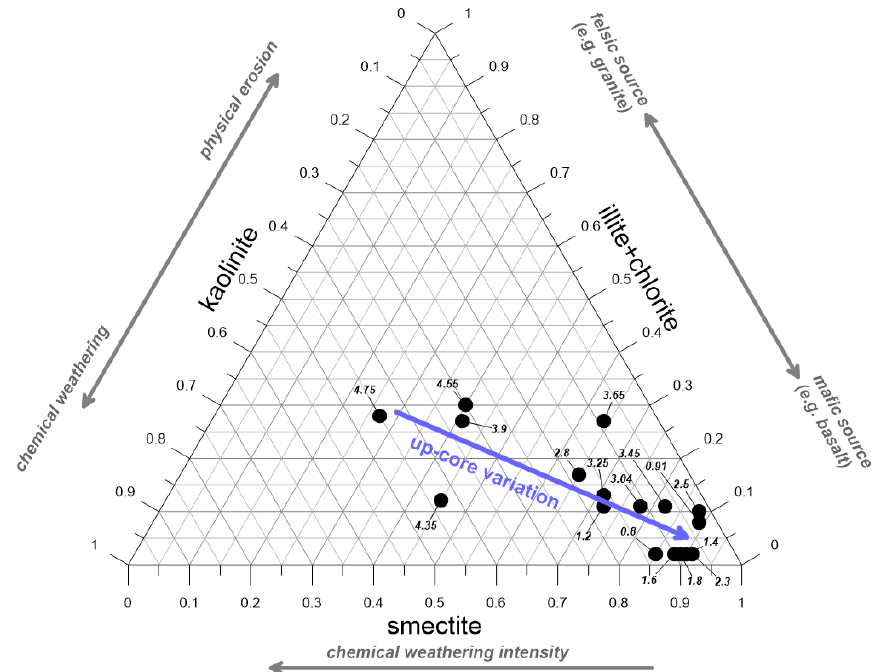
Figure 3. Ternary diagram of the major clay-mineral groups illite-chlorite, kaolinite, and smectite [31]. This clay-mineral assemblage reflects both source-rock lithology and past climate. Kaolinite and smectite abundances are proxies for weathering intensity, whereas the illite-chlorite abundance depends upon the lithology of source rocks.